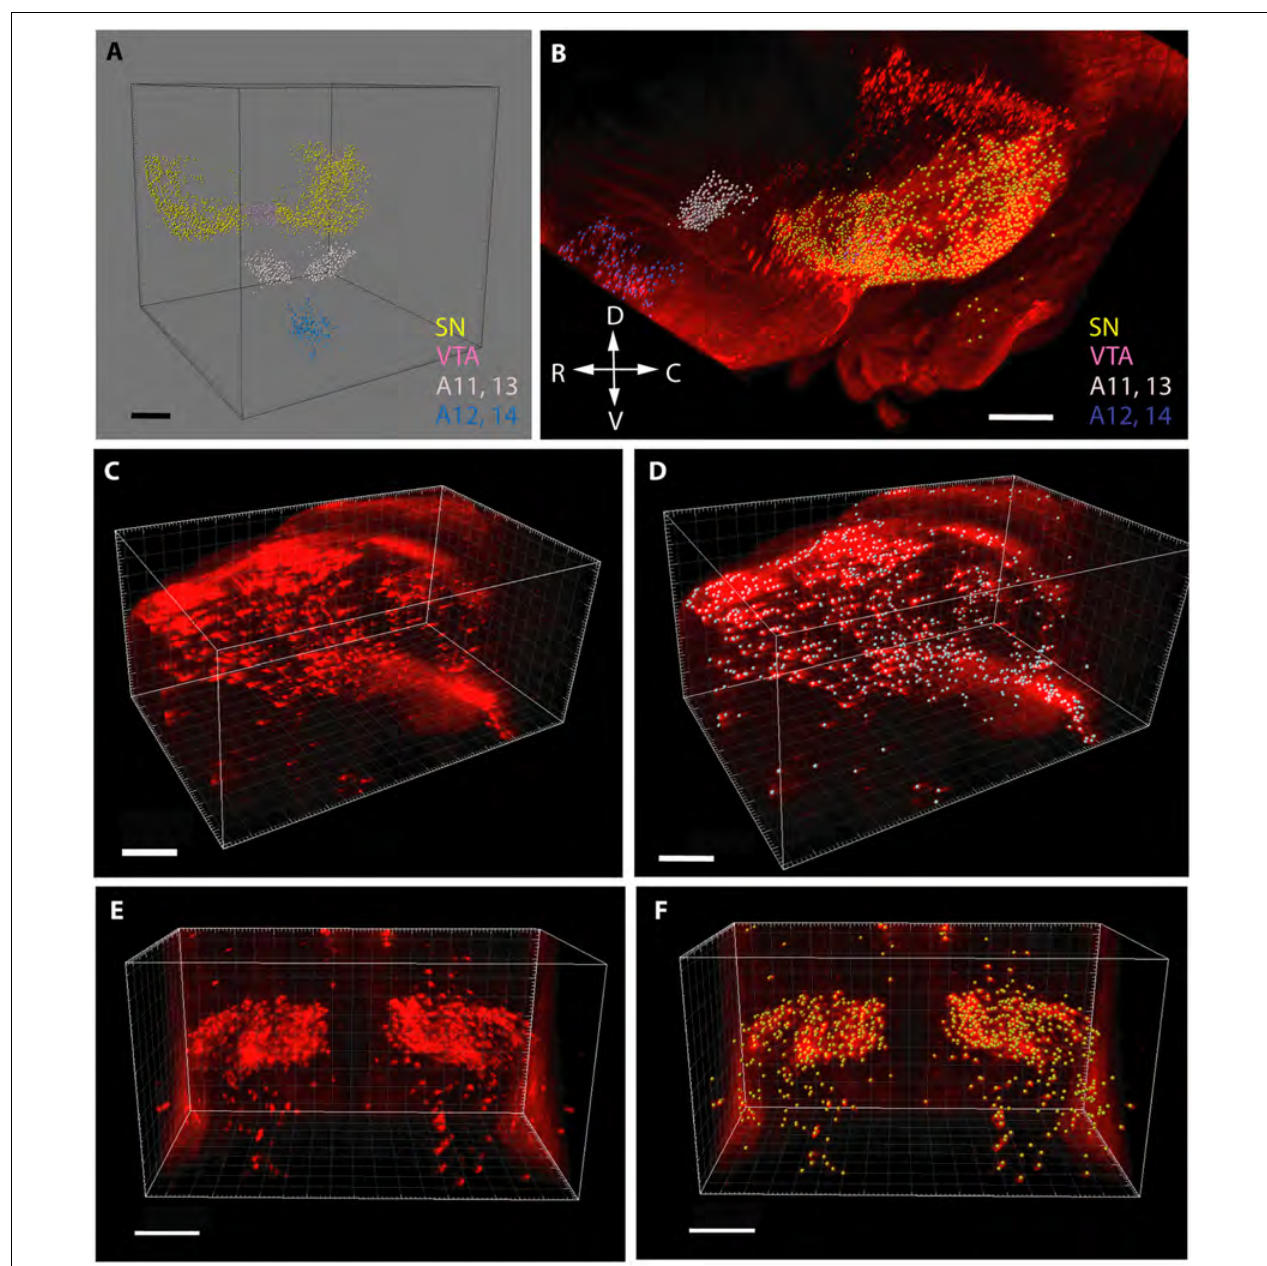
FIGURE 1 | Segmentation and volume rendering of catecholaminergic diencephalic and mesencephalic cell groups with IMARIS, version 8.3.0, on images from representative control brain specimens immunostained for tyrosine hydroxylase (TH), using the iDISCO method. (A) Schematic representation of the false colors used for the demonstration of catecholaminergic structures, after digital subtraction of tissue background. (B) Color-coded catecholaminergic structures shown in their original three-dimensional position (SN—substantia nigra, VTA—ventral tegmental area, A11–13-lateral hypothalamic/incertohypothalamic catecholaminergic cell groups, A12–14-periventricular hypothalamic cell groups). The directions of the compass rose: D, dorsal; R, rostral; V, ventral; C, caudal. (C,D) Segmentation and volume rendering of the SN before (C) and after (D) the automated generation of an array of voxels (measuring spheres) for cell counting. (E,F) Segmentation and volume rendering of the A11–13 area before (E) and after (F) the automated generation of an array of voxels (measuring spheres) for cell counting. Scale bars: (A,B) 500 µ m, (C–F) : 300 µ m.